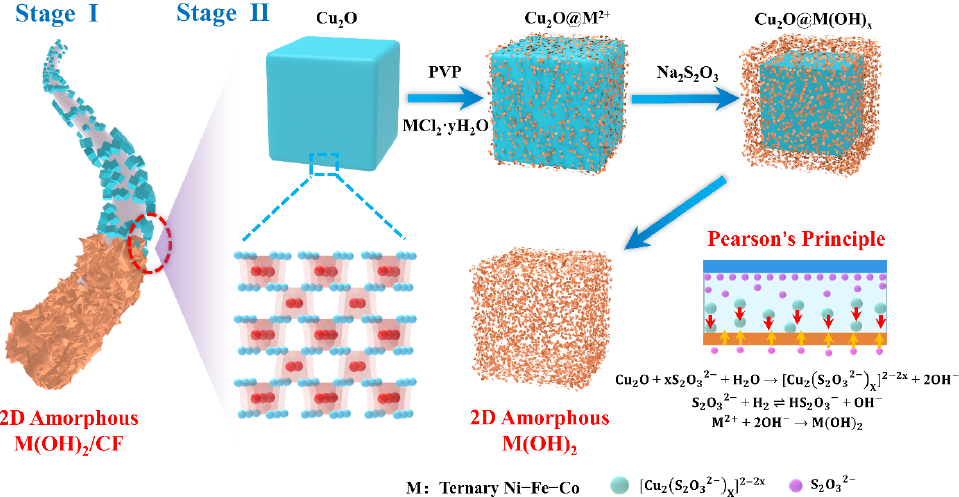
Figure 1. Two ‐ dimensional (2D) amorphous M(OH) 2 growth mechanism based on Pearson’s Figure 1. Two-dimensional (2D) amorphous M(OH) 2 growth mechanism based on Pearson’s HSAB Principle. HSAB